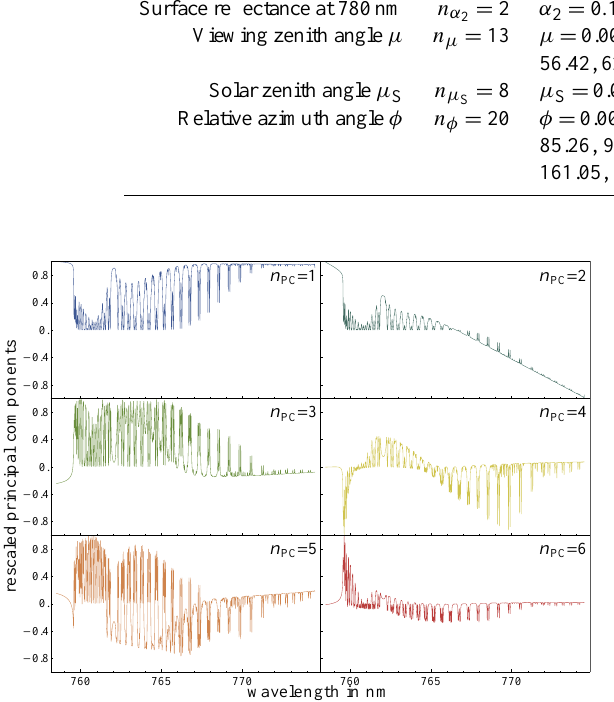
Figure 2. The first six principal components of the principal com- ponent matrix P n . The spectra are normalized for better graphical p representation.